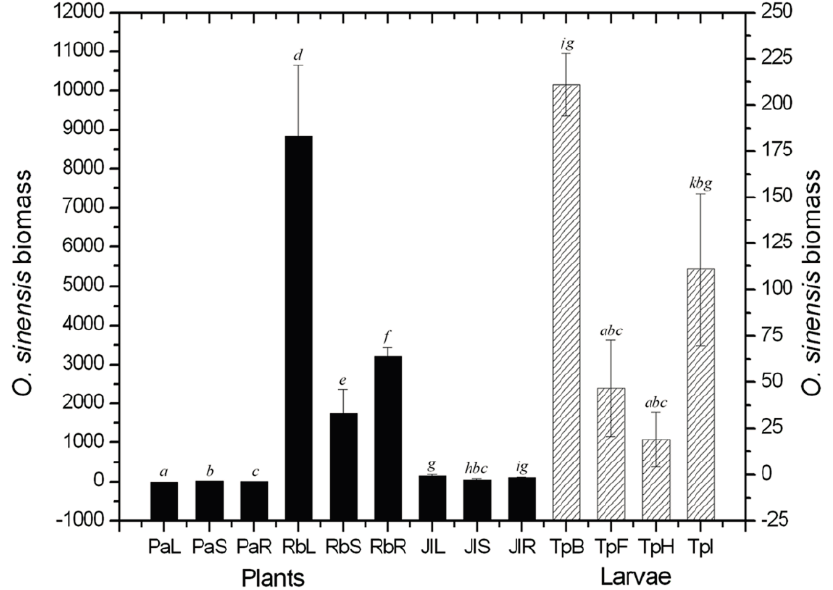
Figure 1. Biomass of O. sinensis in different tissues of the caterpillars and the dominant plants in Nyingch prefecture. PaL: Primula alpicola leaf; PaS: P. alpicola stem; PaR: P. alpicola root; RbL: Ranunculus tanguticus leaf; RbS: R. tanguticus stem; RbR: R. tanguticus root; JlL: Juncus leucanthus leaf; JlS: J. leucanthus stem; JlR: J. leucanthus root; TpB: Thitarodes pui body-wall; TpF: T. pui fat-body; TpH: T. pui haemolymph; TpI: T. pui intestinal-wall. Differences between means at p < 0.05 are indicated by different letters (bars with the same letter are not significantly